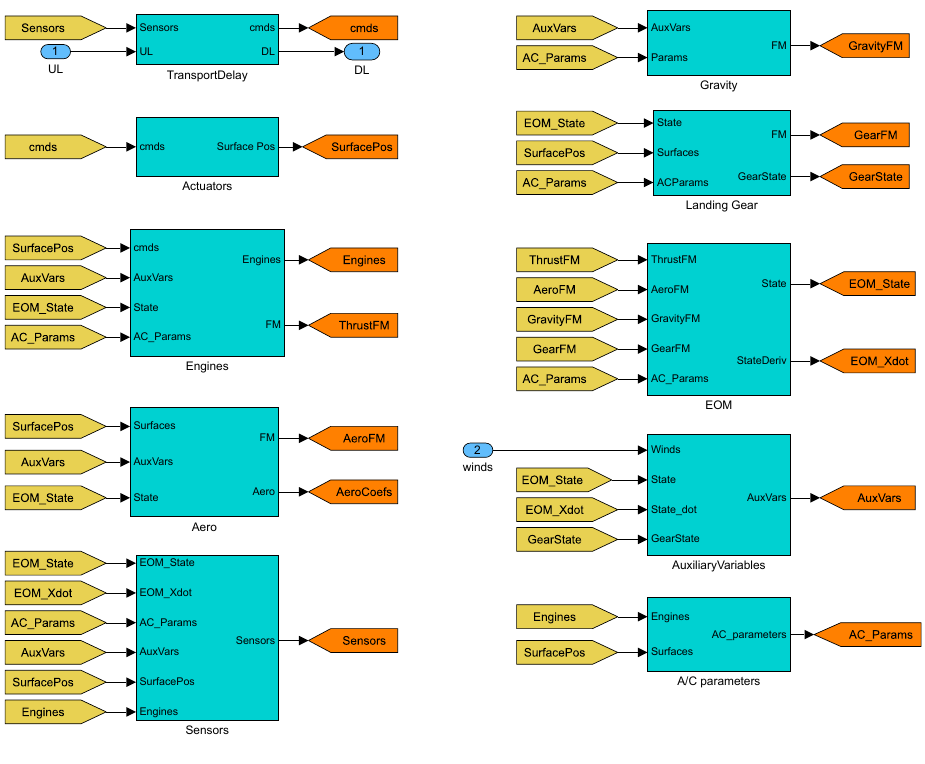
Figure 5. Building blocks of